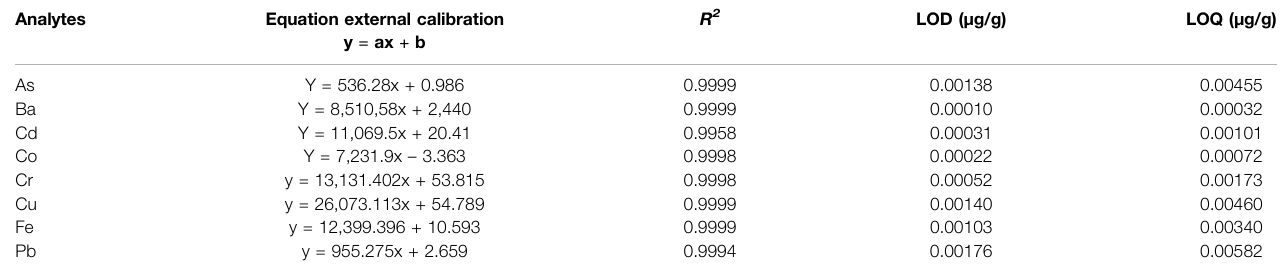
TABLE 3 | Calibration equations, correlation coef fi cients ( R 2 ), LOD and LOQ obtained by external calibration. Analytes Equation external calibration y = ax + b As Y (cid:1) 536.28x +